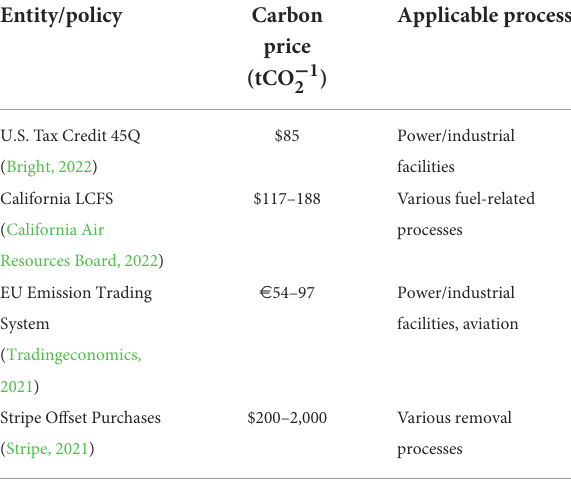
TABLE 1 Carbon prices currently paid by public policies and private